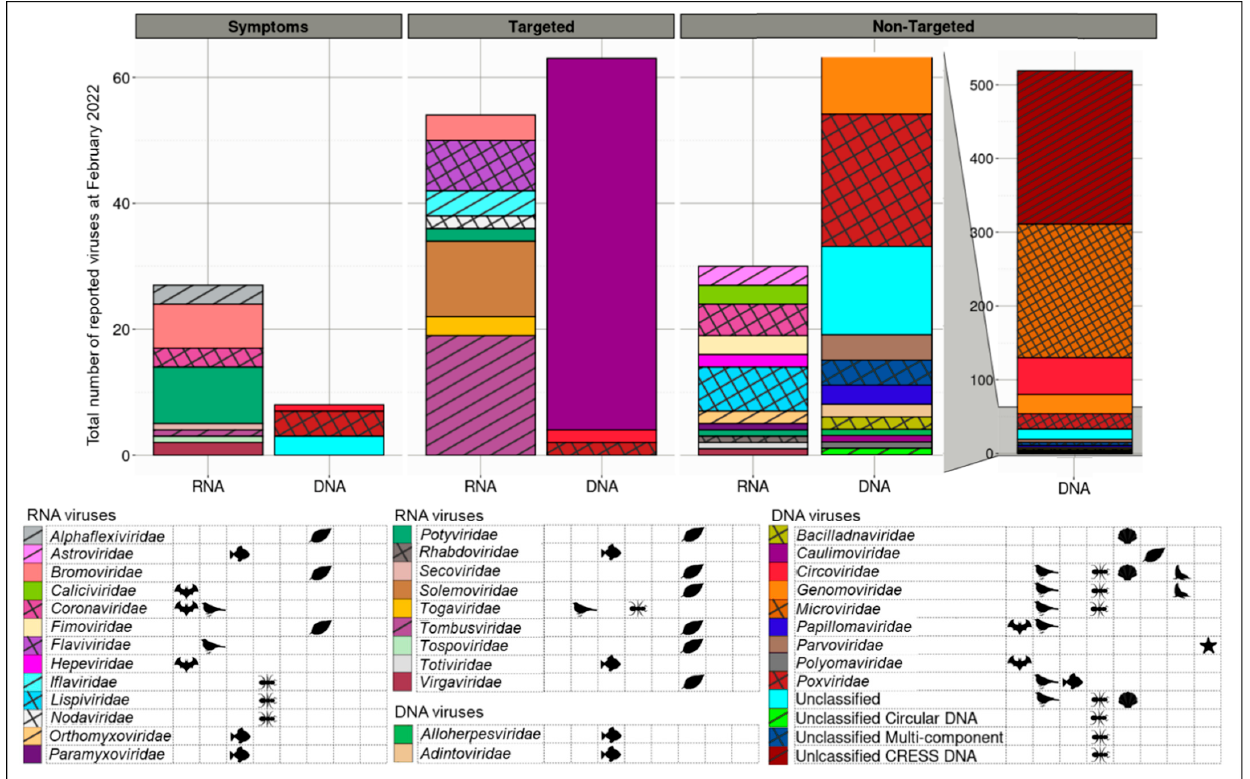
Figure 4. Total number of reported viruses associated with Aotearoa New Zealand indigenous hosts as of February 2022, compared based on identification method and viral family. Identification method refers broadly to how a virus was discovered in a New Zealand indigenous host. ‘Symptoms’ refers to viruses detected by symptom observation. ‘Targeted’ refers to viruses identified via targeted approaches with known viruses. ‘Non-targeted’ refers to broad-spectrum viral identification (for DNA viruses there are two columns, as indicated by the grey shading; the left column is a subset of the right one, which has its own scale). Viral families are split into RNA and DNA, and the hosts in which these viruses have been reported during the course of this meta-analysis have been identified via associated symbols: bats , birds , fish , insects , mollusks , plants , seals , and starfish .